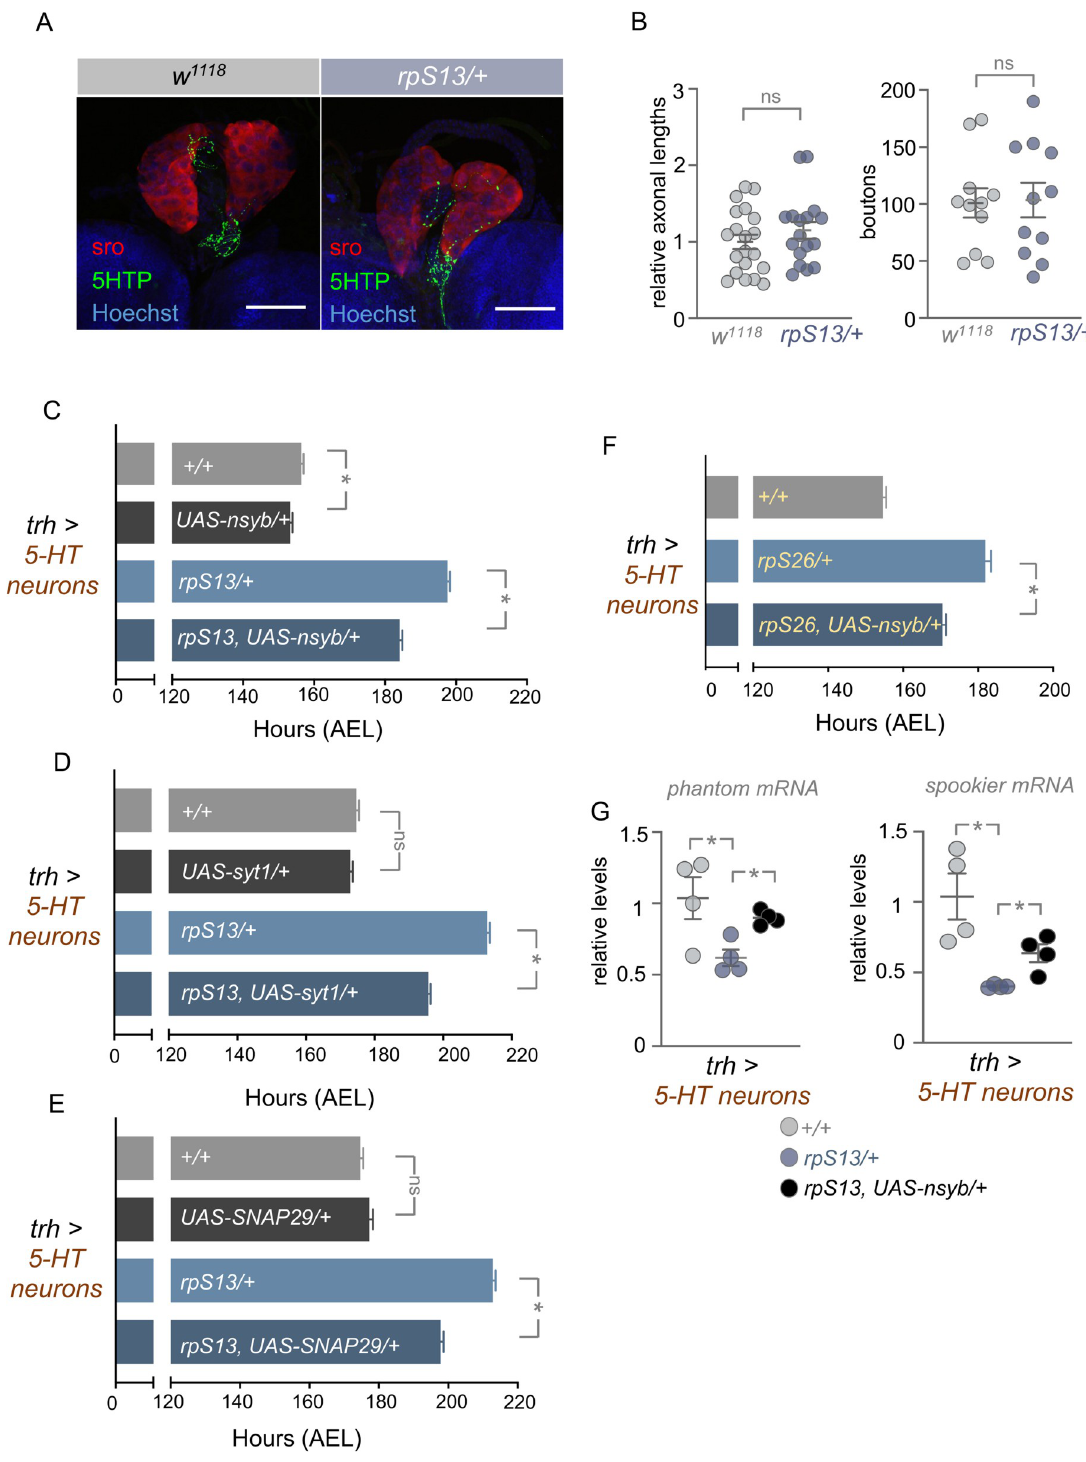
Fig 7. Expression of individual SNARE complex proteins partially rescues rpS13/+ developmental delay. (A) Fluorescent confocal images of representative +/+ and rpS13/+ prothoracic glands showing innervation of serotonergic neurons. Anti- 5-HTP is labelled with GFP, while the prothoracic gland is labelled in red using an anti-shroud antibody. Nuclei of both the brain and prothoracic gland are stained with Hoechst. Scale bars, 50 μ m. (B) Quantification of relative axon lengths (left) and bouton numbers (right) of 5-HT neurons that overlap the prothoracic gland. Individual data points are plotted, and the bars represent mean +/- SEM. ns = not significant,